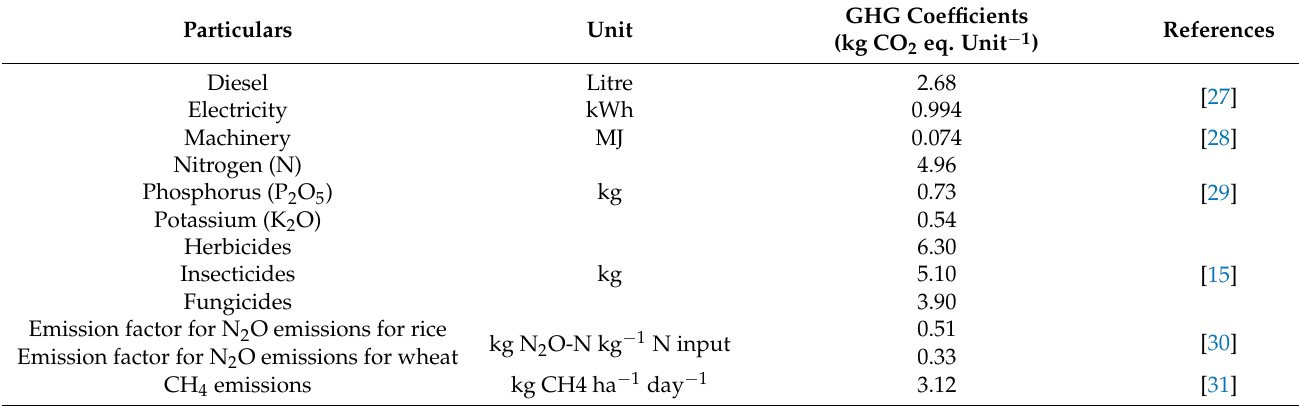
Table 4. Greenhouse gas (GHGs) emission coefficients of inputs in rice–wheat production.